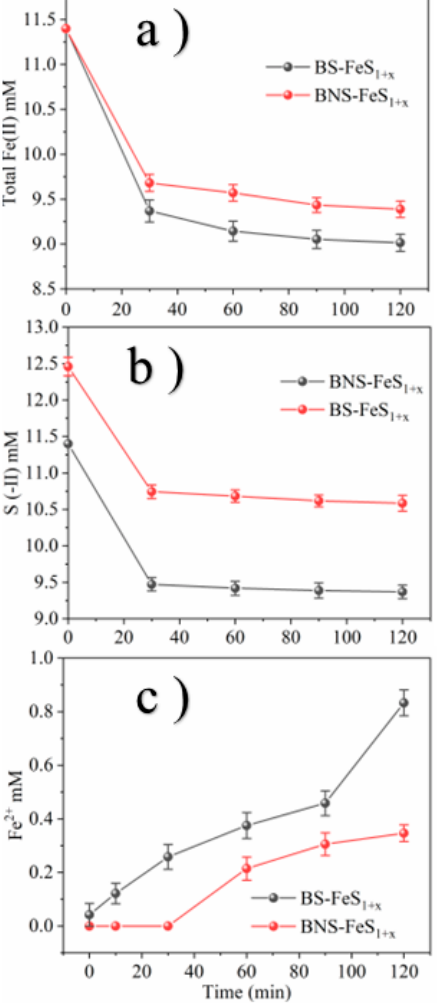
Figure 5. Changes in the concentration of Fe(II) and S(-II) when Cr(VI) is removed from the suspension of BS-FeS 1+x and BNS-FeS 1+x . ( a ): Fe(II) concentration change, ( b ): S(-II) concentration change, and ( c ): Fe 2+ concentration change. Reaction conditions: FeS 1+x dosage concentration was 11.4 mM; Cr(VI) dosage concentration was 1.14 mM; initial pH was 5.0; reaction time was 2 h; and speed was 200 rpm. BS-FeS 1+x : biosynthesis of iron sulfides containing SRB. BNS-FeS 1+x : biosynthesis of iron sulfide dry particles without SRB. Data were plotted as means of duplicates, and the error bars indicate the standard deviation.